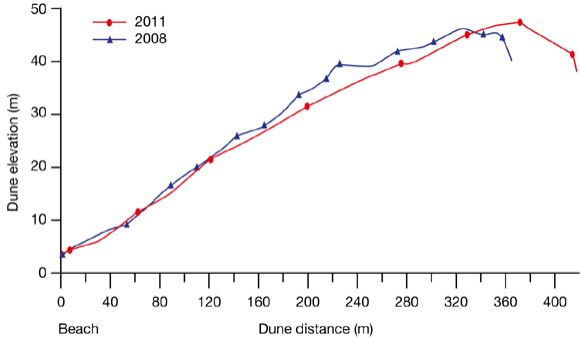
Fig. 7. – Topographic evolution of the Bolonia dune profile (B1) from 2008 to